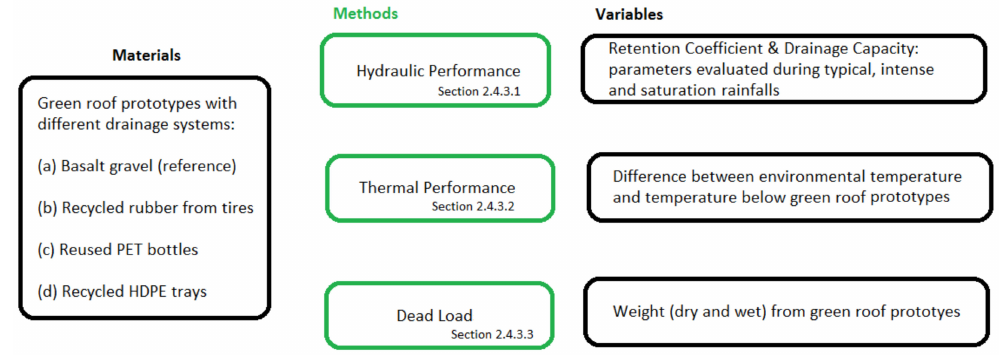
Figure 5. Main variables monitored on the green roof